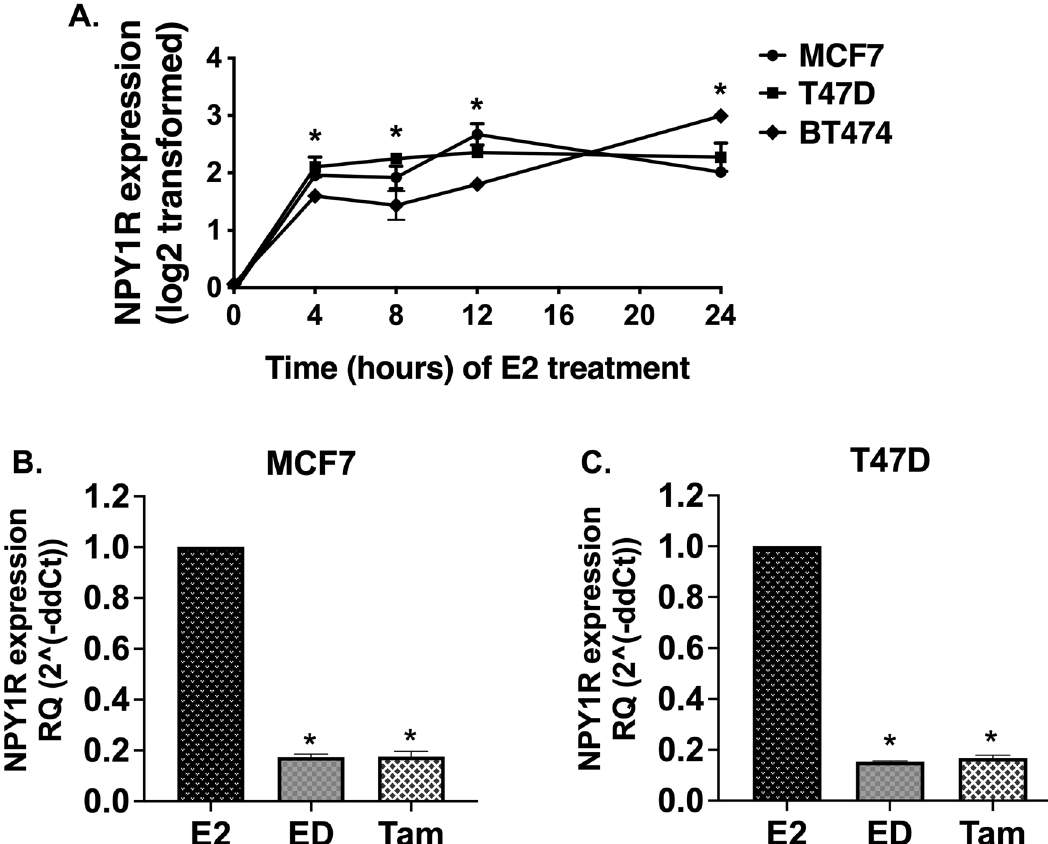
Figure 3:. 17β-Estradiol (E2) treatment induces NPY1R gene expression in a time-dependent manner and endocrine therapy downregulates NPY1R gene expression in ER+ BC cells. ( A ) Data presented is derived from microarray-based gene expression profiles from three ERα-positive breast cancer cell lines (MCF7, T47D and BT474) stimulated by (E2) in vitro over a time course 0–24 h. RNA was isolated, and the gene expression profiles were determined using Affymetrix Genechip Arrays. Arrays were normalized and compared using DNA-Chip Analyzer software (dChip), (http:// www. dchip. org/) (GEO: GSE3834) 35 . Gene expression values were log-transformed. NPY1R probe: 205440_s_at. Each data point represents the mean of duplicates (BT474 at 12 h is an individual value). Error bars show the SD (automatically calculated by GraphPad prism). ( B ) MCF7 and ( C ) T47D cells grown in charcoal-stripped media were treated with E2, estrogen deprivation (ED), or ED + tamoxifen (Tam). Total RNA was extracted for qPCR analysis and the fold change data were plotted as RQ (2 (− ddct) ). *indicates statistically significant difference compared to 0 h time point or E2; *indicates p < 0.05 by One-way ANOVA, Dunnett’s test (n = and the densitometric quantitation of the relative intensity of NPY1R to parental cells (from three independent experiments) are shown in Supplementary Fig. 5. Inhibition of E2‑stimulated cell growth by NPY is mediated via NPY1R. 5B). The inhibitory effect of NPY on E2-stimulated cell growth was reversed by treatment with BIBP-3226, a selective non-peptide antagonist of NPY1R 46–50 , in MCF7 and T47D cells (Fig. 5C and 5D). Notably, BIBP-3226 had no significant effects on non-E2-stimulated cell growth in MCF7 and T47D cells (Supplementary Fig. 6). NPY1R is a prognostic marker in ER+ and LumA BC. (Fig. 6A) and OS [HR = 0.62 (range: 0.43–0.89, logrank P = 0.009)] (Fig. 6B). In ER− BC patients, higher NPY1R gene expression was not predictive of RFS [(HR = 0.8 (range: 0.64–1.01, logrank P = 0.055) (Fig. 6C) but was associated with better OS [(HR = 0.61 (range: 0.38–0.97, logrank P = 0.034)] (Fig. 6D). In METABRIC dataset, high NPY1R expression predicted significantly longer BCSS in LumA (n = 678, logrank P = 0.0147) tumors but not in Lum B tumors (Supplementary Fig. 7).